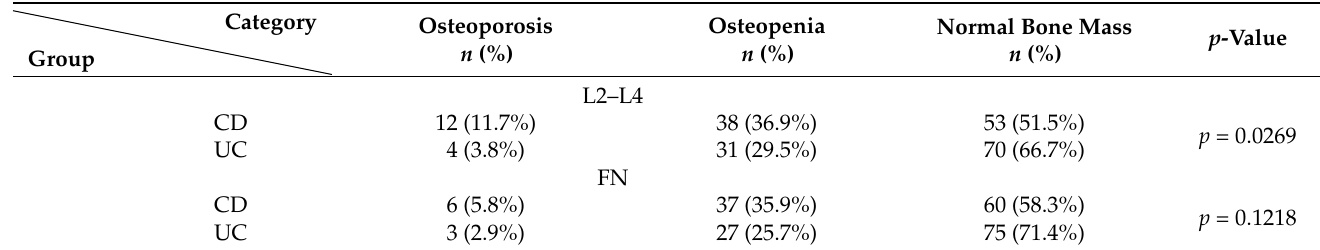
Table 1. Prevalence of osteoporosis, osteopenia, and a normal bone density of the lumbar spine L2-L4 level and the femoral neck, based on T-scores, in patients with Crohn’s disease and ulcerative colitis.